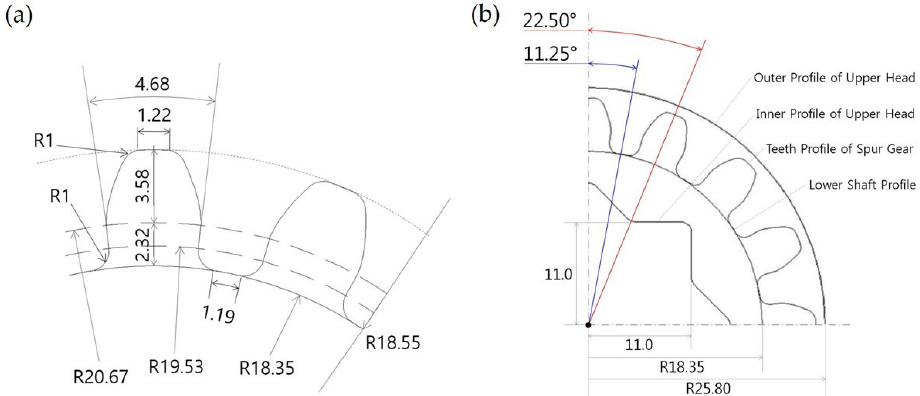
Figure 4. Geometric illustrations of tooth profile and overlapped cross-sections of drive shaft (unit: mm): ( a ) Tooth geometries of spur gear; ( b ) Overlapped cross-sections.